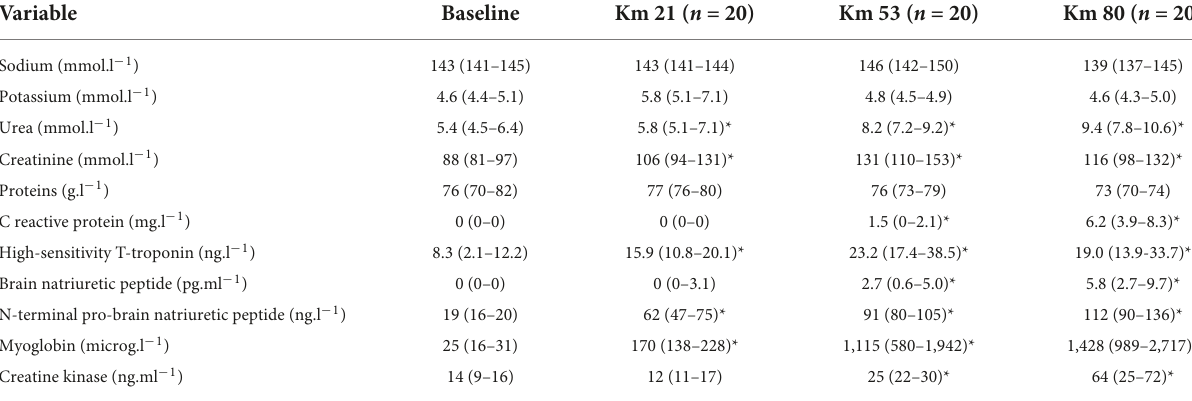
TABLE 3 Evolution of biomarkers in the 20 amateur ultra-distance and trail runners.